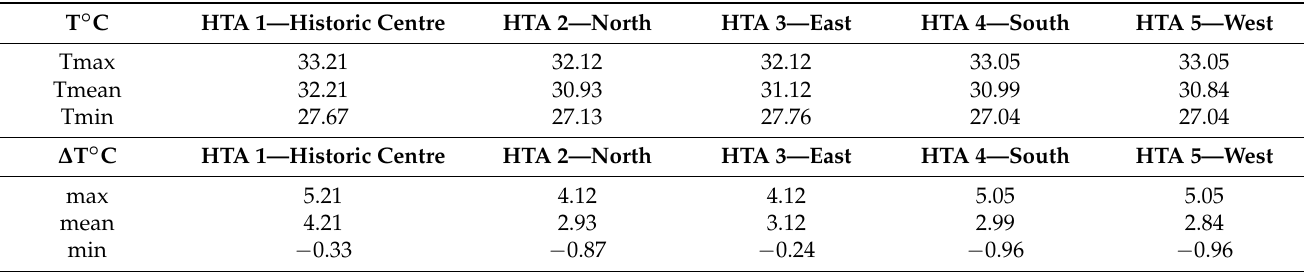
Table 3. Simulated temperatures in the HTAs and temperature differences compared to the values recorded at the reference weather station at 10